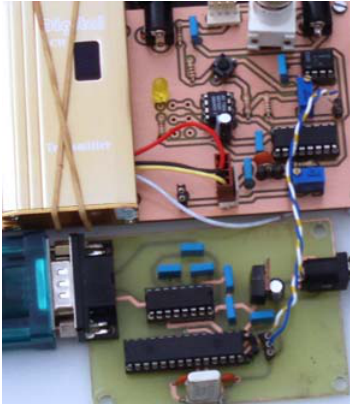
Figure 5. Terminal 1 Photograph, RF-transmitter Up-left, pulse repeater circuit up-right, and microcontroller circuit board bottom.